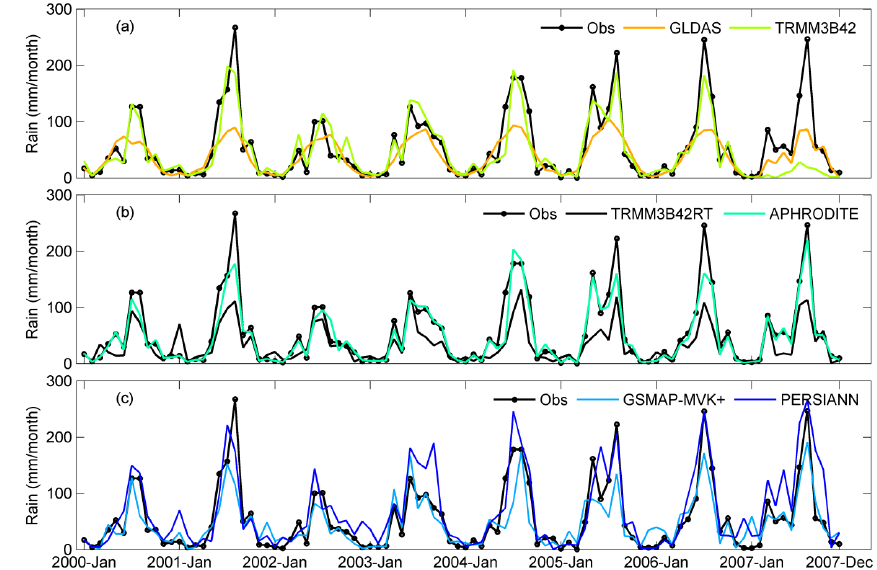
Figure 5. Time series plots of basin-averaged precipitation product values versus gauge observations at a monthly scale.